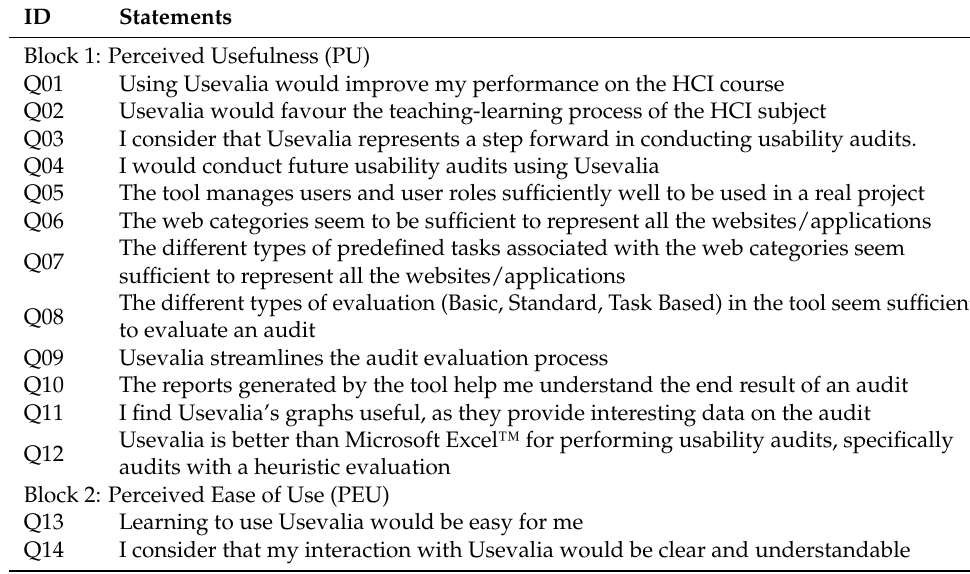
Table 3. TAM questionnaire used for the evaluation of